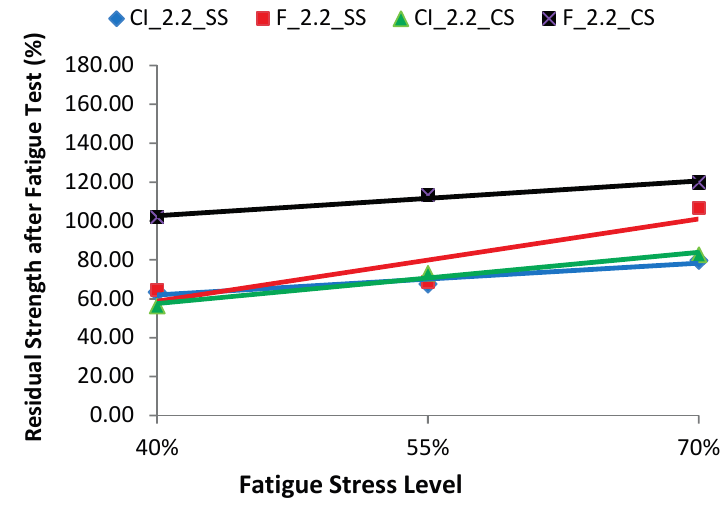
Figure 8. Percentages of residual strength after fatigue test.